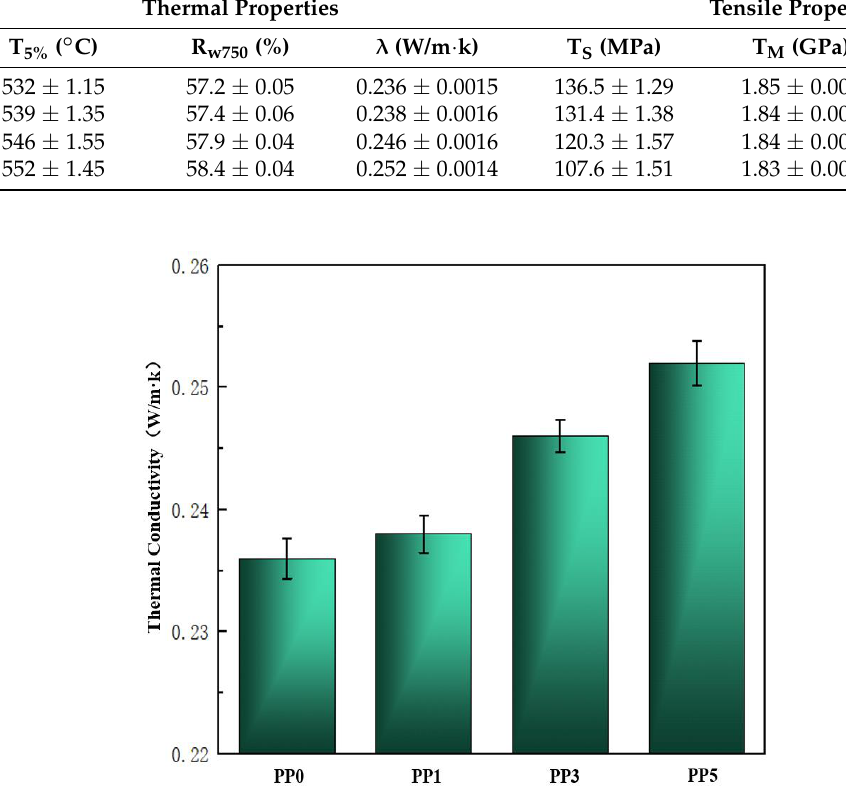
Figure 6. Thermal conductivity of films.